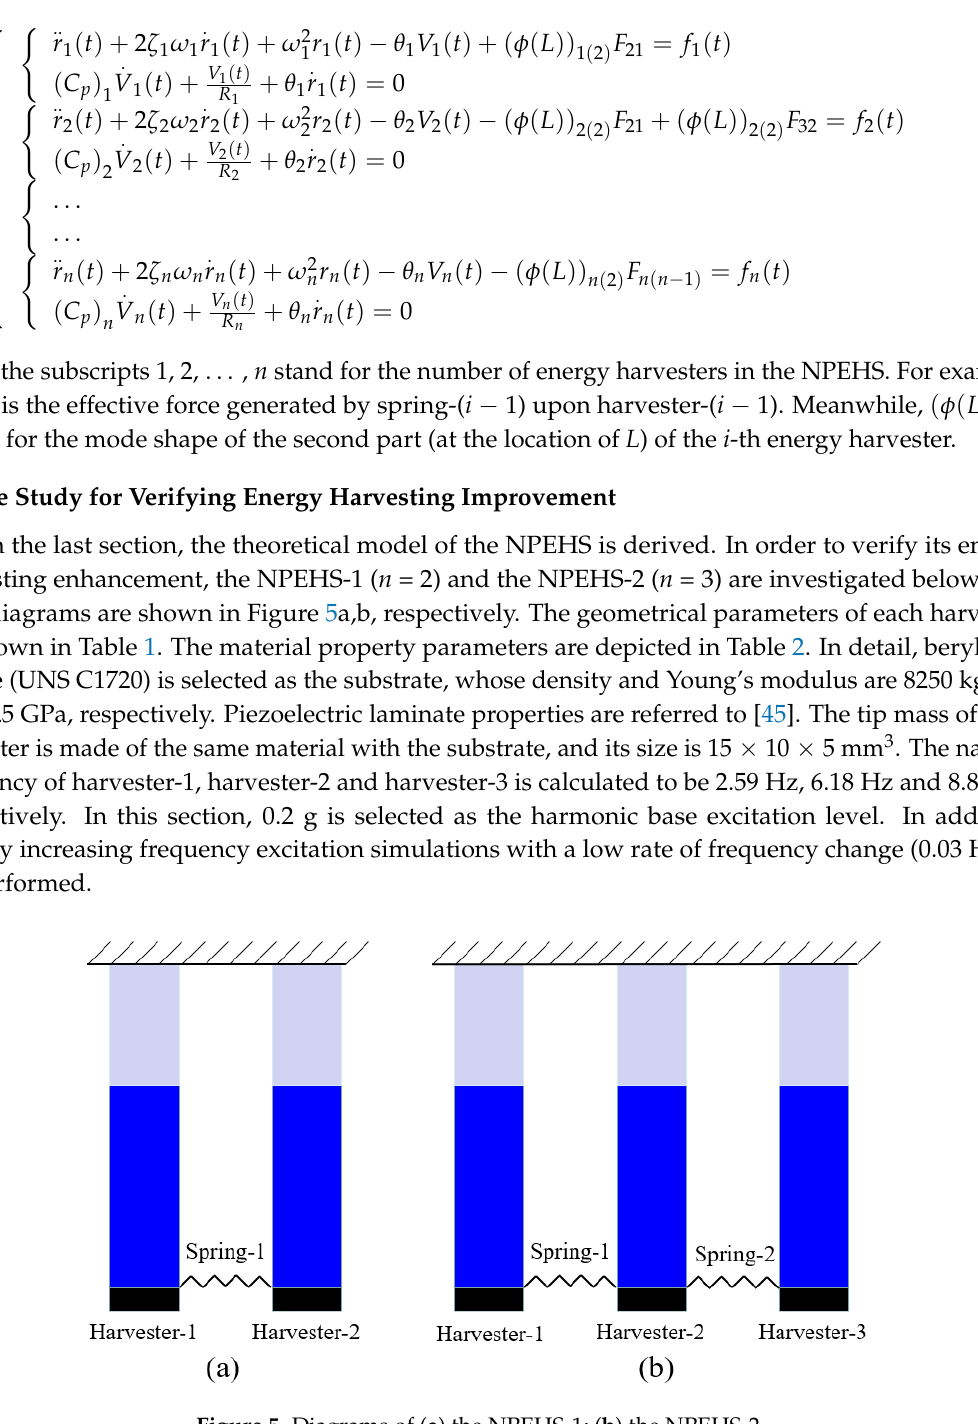
Figure 5. Diagrams of ( a ) the NPEHS-1; ( b ) the NPEHS-2.